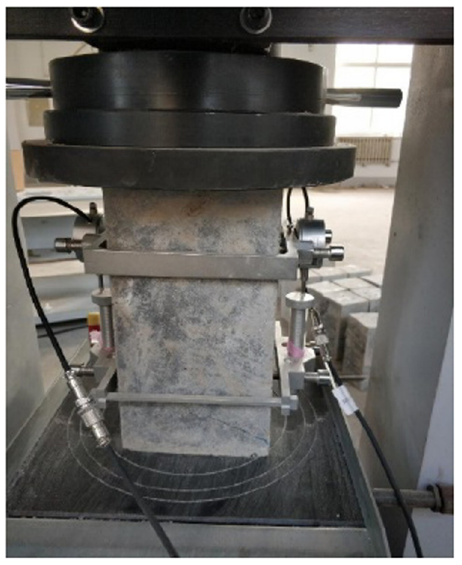
Figure 2: Testing apparatus of elastic modulus test.